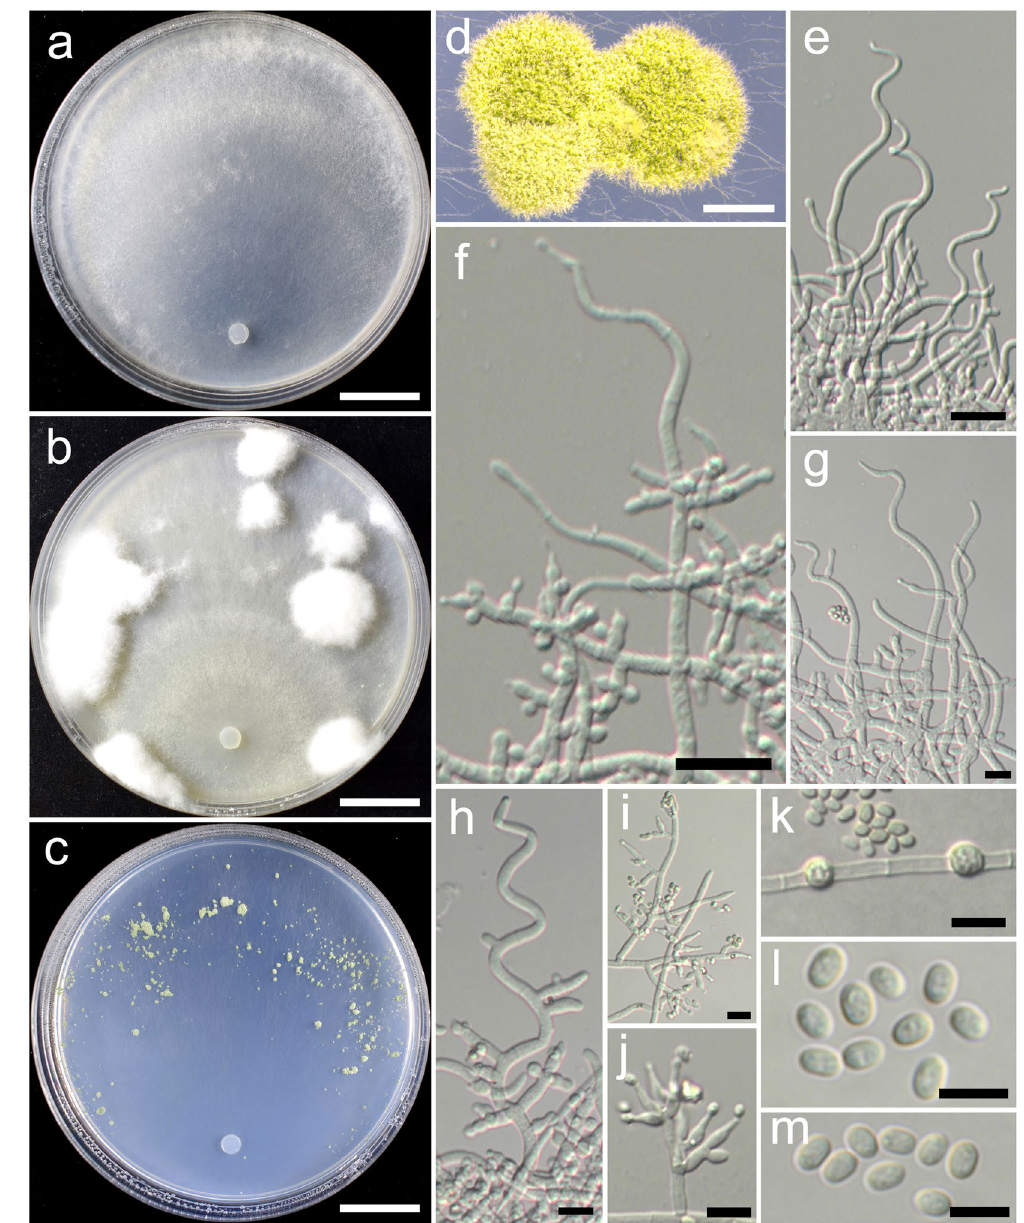
Figure 7. Trichoderma byssinum (HMAS 248838). ( a – c ) Cultures at 25 °C, 10 d (a. on CMD; b. on PDA; c. on SNA); ( d ) Conidial pustules (SNA, 7 d); ( e – h ) Pachybasium-like conidiophores and phialides (SNA, 7 d); ( i , j ) Verticillium-like synanamorph (PDA, 7 d); ( k ) Chlamydospores (SNA, 7 d); ( l – m ) Conidia (SNA, 7 d). Bars: a–c = 20 mm. d = 400 μ m. e–f = 20 μ m. g–k = 10 μ m. l–m = 5 μ